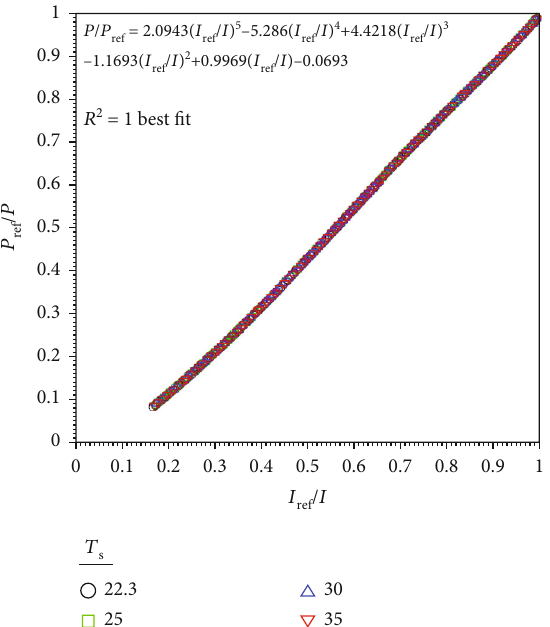
Figure 6: PSP calibration at di ff erent temperatures: 22.3, 25, 30, and 35 ° C.